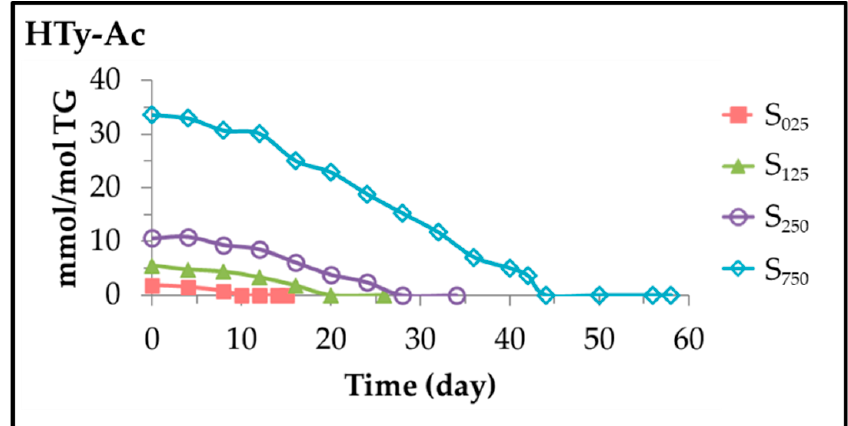
Figure 3. Evolution of the concentration of HTy-Ac, expressed in mmol/mol TG, in samples S 025 , S 125 , S 250 and S 750 over the storage time at 70 °C, up to a very advanced oxidation stage.